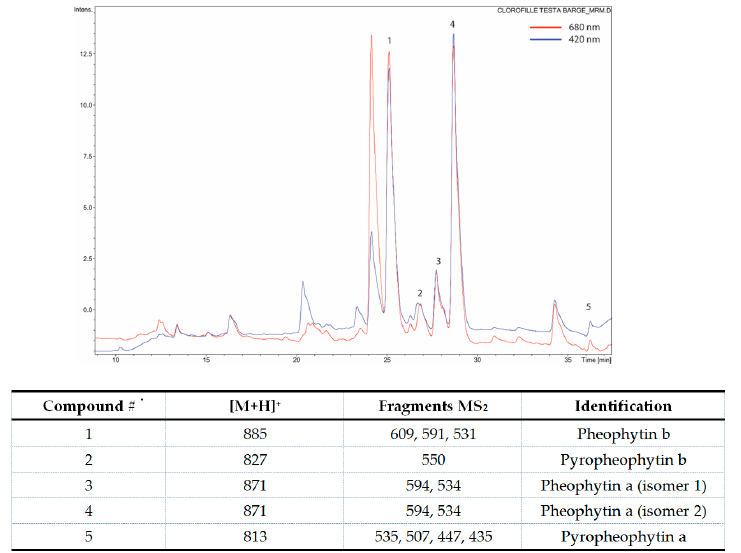
Figure 1. HPLC-MS chromatogram with [M + H] + mass fragments identification. Chlor for the analysis was dissolved in acetonitrile/methanol/water 70:20:5, v/v.